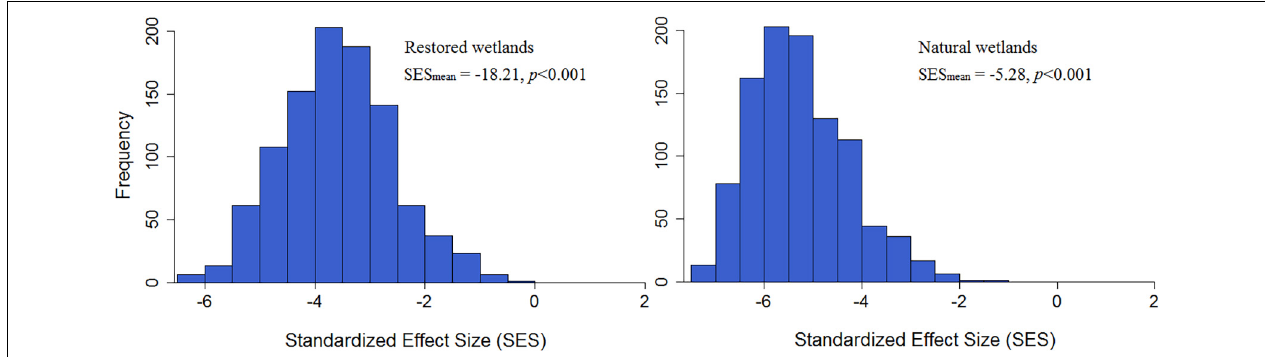
FIGURE 5 | Frequency histograms of standardized effect sizes measured in presence-absence matrices. The blue bars in this figure are standard histograms of simulated metric